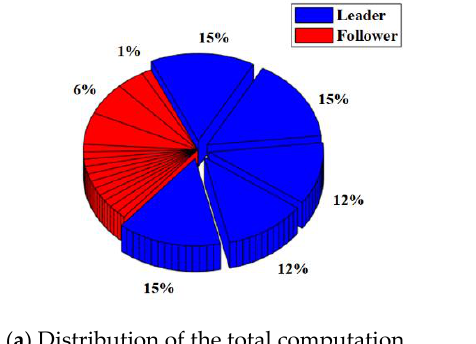
Figure 12. Resource occupation of the RIPPLE algorithm with no malicious nodes.